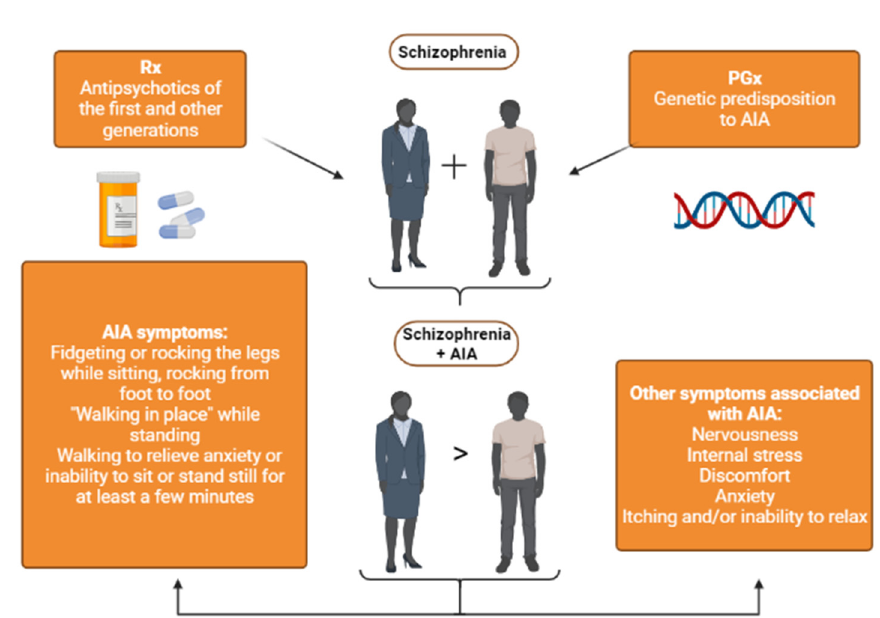
Figure A1. The clinical picture of antipsychotic-induced akathisia (AIA) in patients with schizophre- nia (Sch). Note: Rx-prescription and PGx-pharmacogenetics.